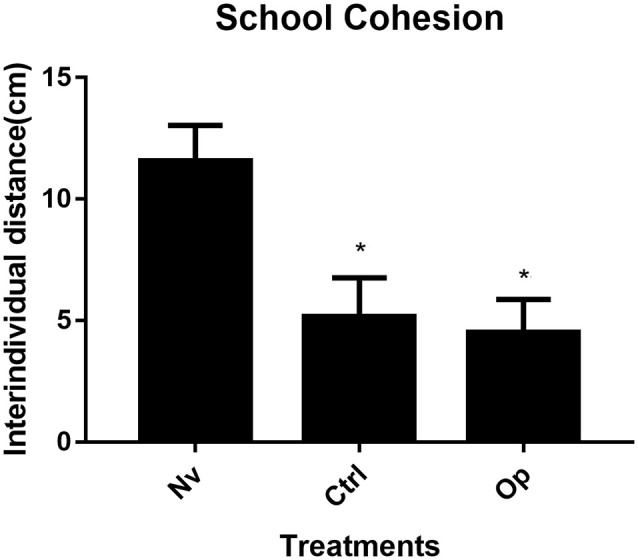
Average interindividual distance (n:3; pool 4) measured from 30 image frames extracted from 5 min behavioral record. Data were expressed as mean ± SD for each group and were analyzed by one-way ANOVA (average distance) followed by Tukey’s post hoc test. *Denotes statistical significance from the Naive (Nv) group p < 0.05.